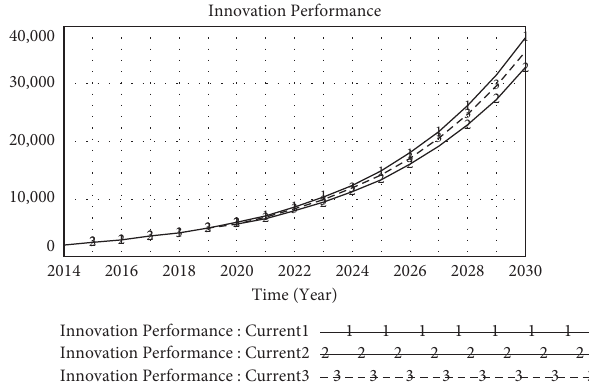
Figure 8: The influence of organizational factors adjustment on innovation